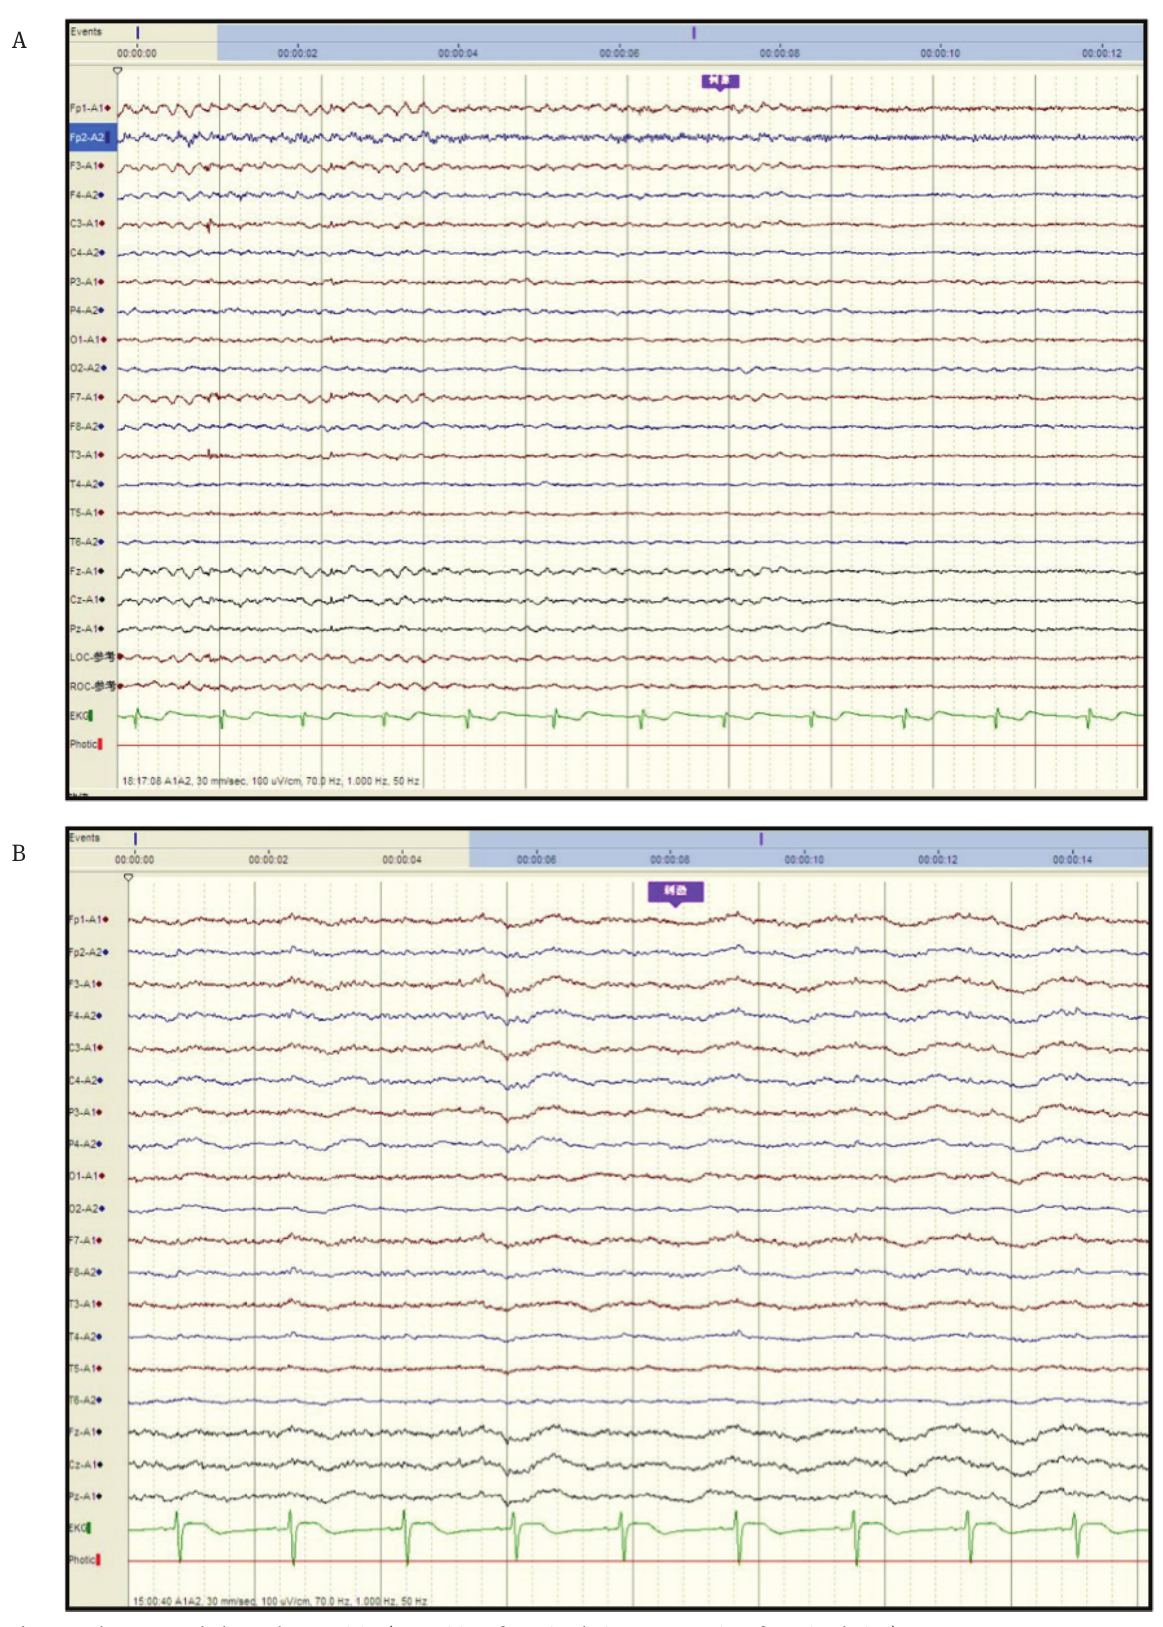
Figure 1: Electroencephalography reactivity ( A: positive after stimulation; B: negative after stimulation